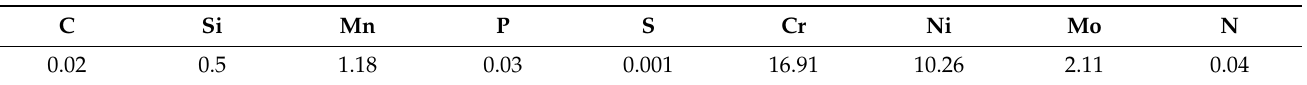
Figure 2. Microstructure of 316L before fatigue experiments. Table 1. Chemical composition in weight percentage of the AISI 316L hot rolled